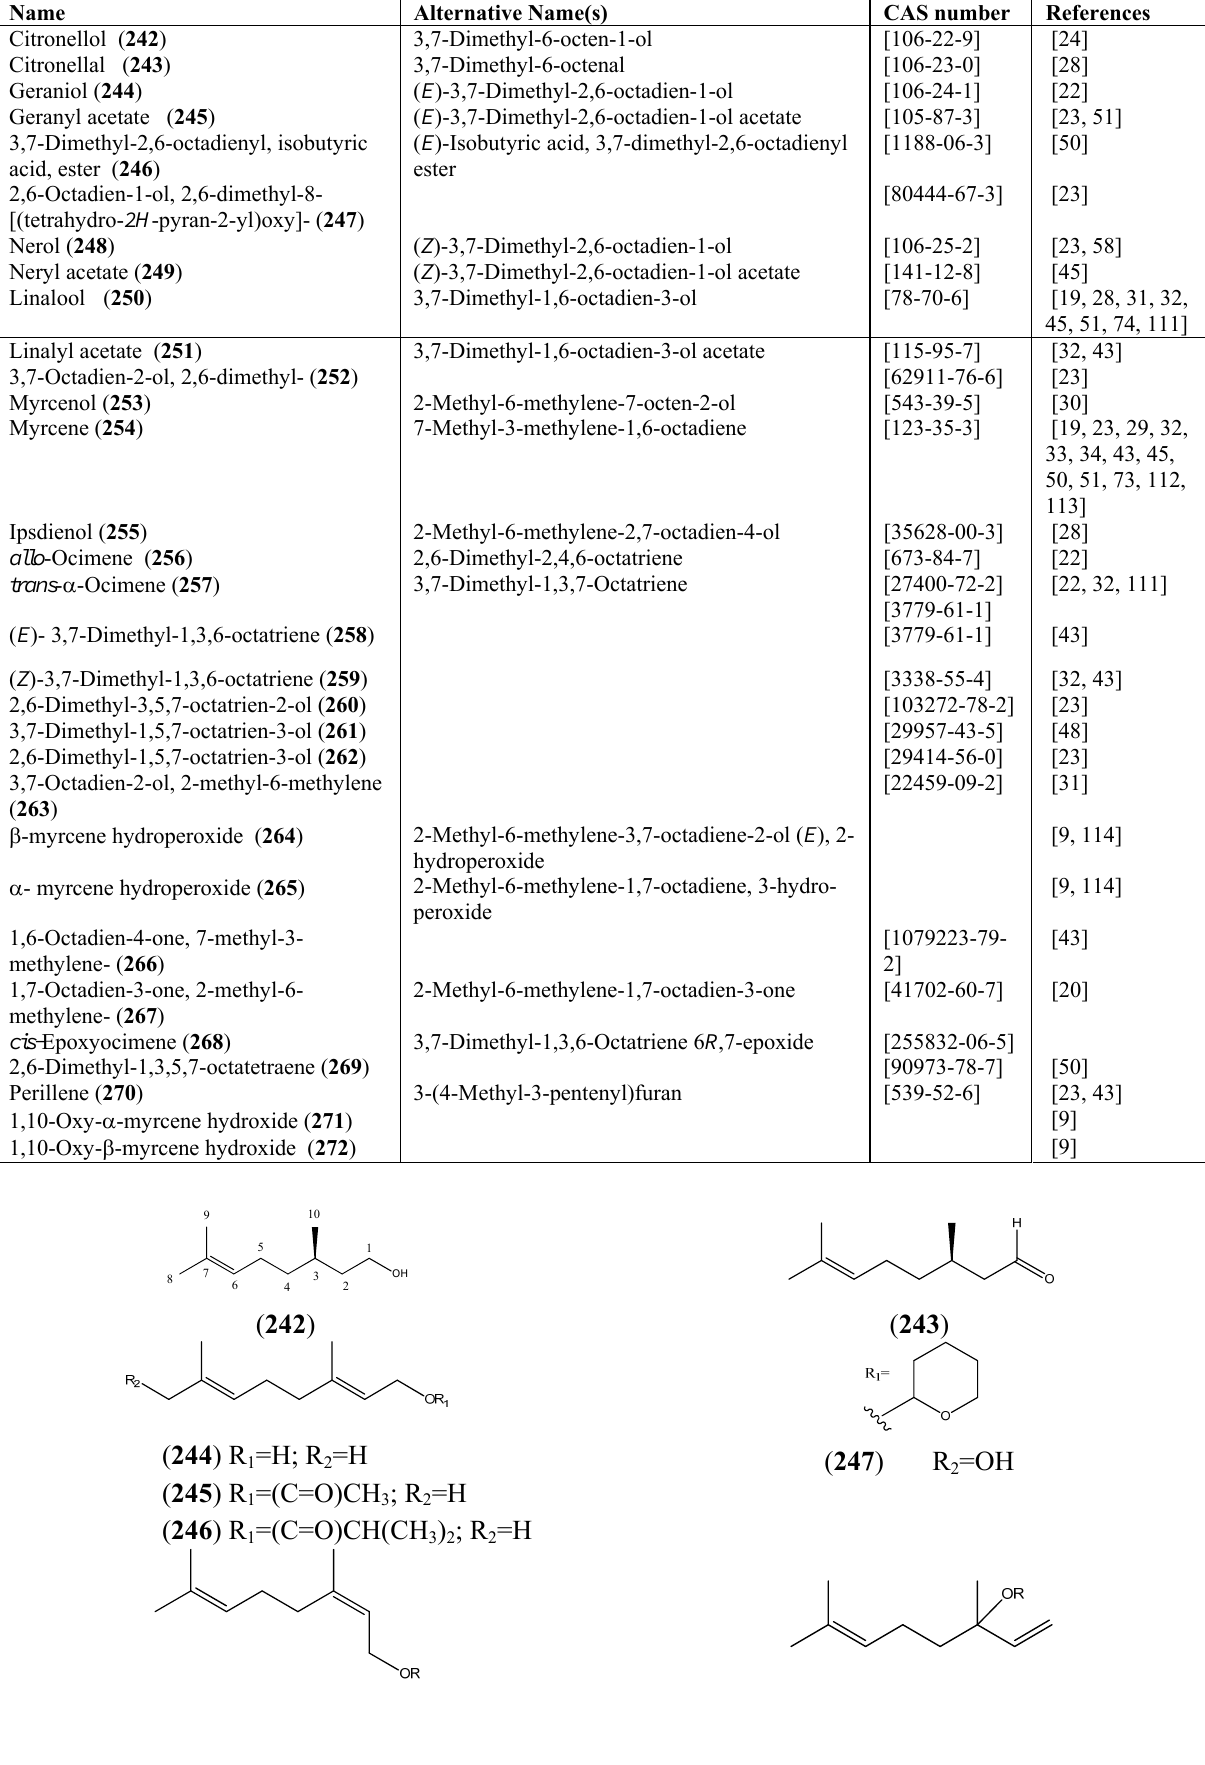
Table 23. Regular Acyclic Monoterpenoids (2,6-Dimethyloctane, 9CI,